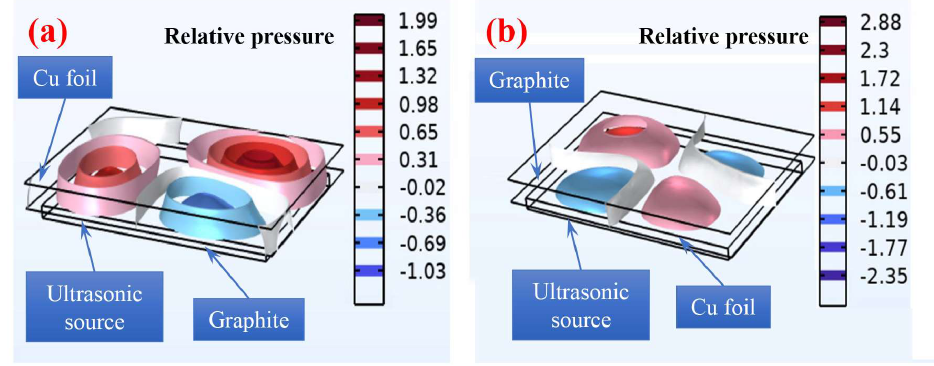
Figure 14. Numerical simulation of layered copper-graphite anode material at various directions toward ultrasonic irradiation source. Rotation of the surface of chunks of anodic material: ( a ) with the proximity of graphite to the ultrasonic source, ( b ) with the proximity of copper to the ultrasonic source.